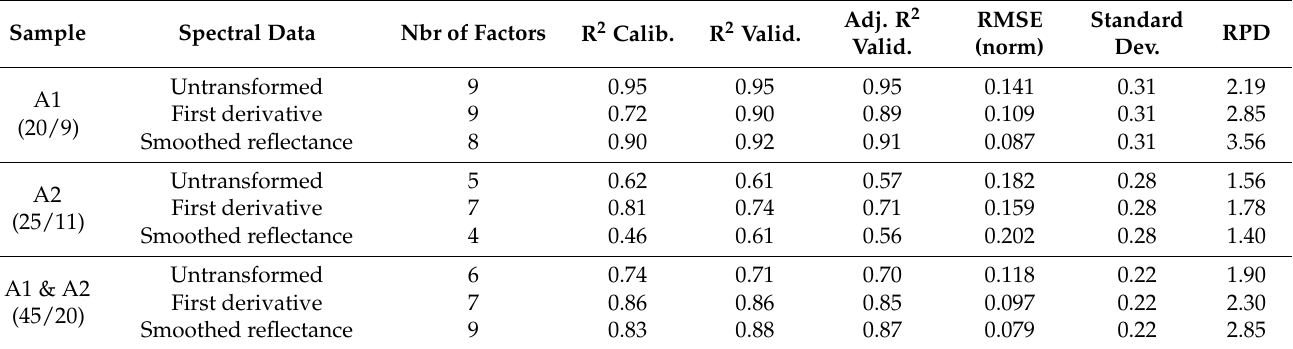
Table 7. PLSR models for SOC prediction after selecting the spectral bands.